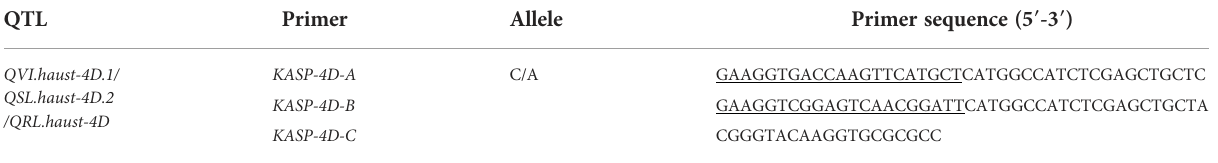
TABLE 4 The primer sequences of KASP marker for QVI.haust-4D.1/QSL.haust-4D/QRL.haust-4D . QTL Primer Allele Primer sequence (5 ′ -3 ′ )